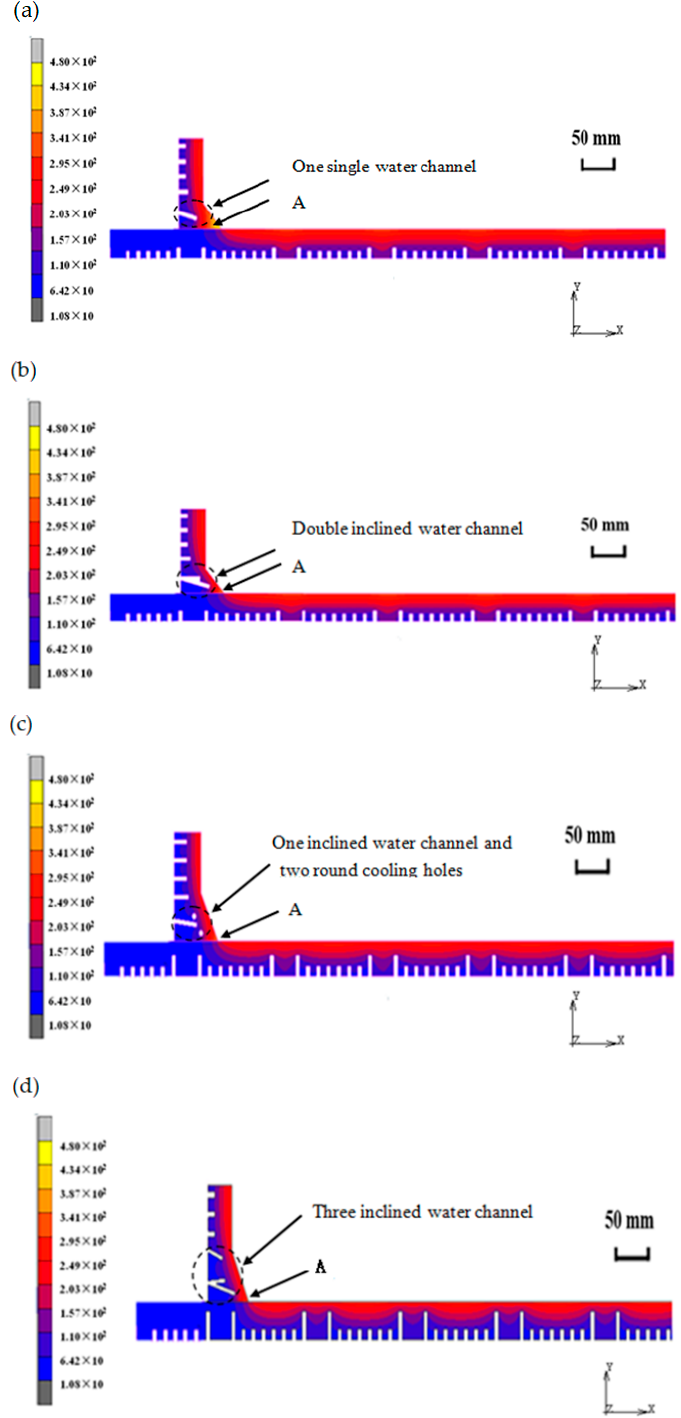
Figure 11. Heat transfer capacities of di ff erent mold schemes. ( a ) One single water channel; ( b ) Double inclined water channels; ( c ) One inclined water channel joint and two round cooling holes; ( d ) Three inclined water